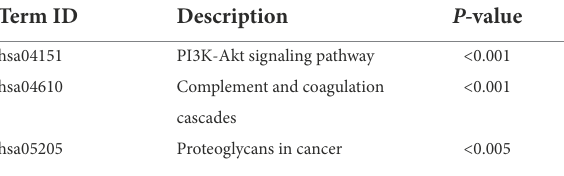
TABLE 4 Protein–protein interaction enrichment analysis revealed three significantly enriched